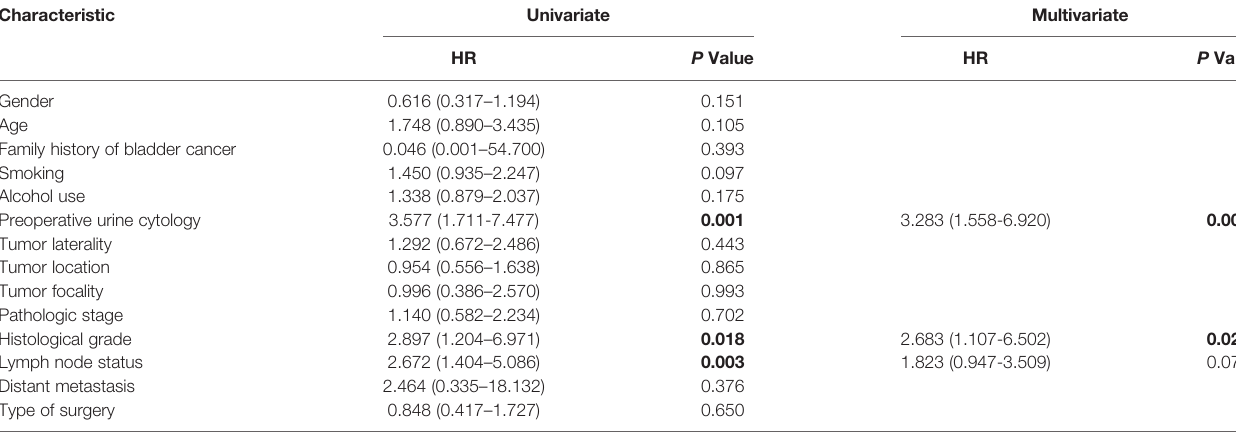
The bold values were applied to highlight P-values which had statistically signi fi cance (i.e. P <